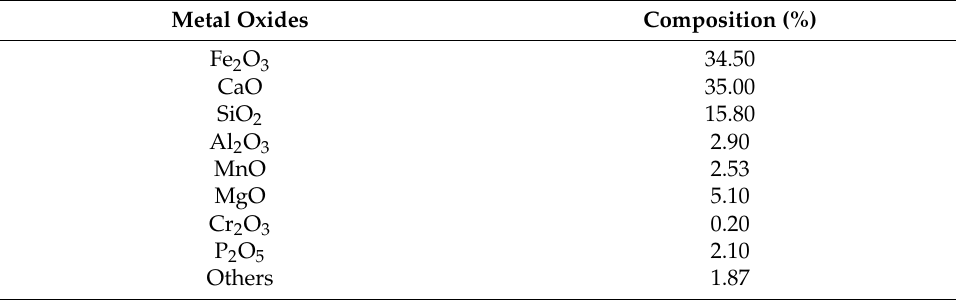
Table 1. Chemical compositions of BOF